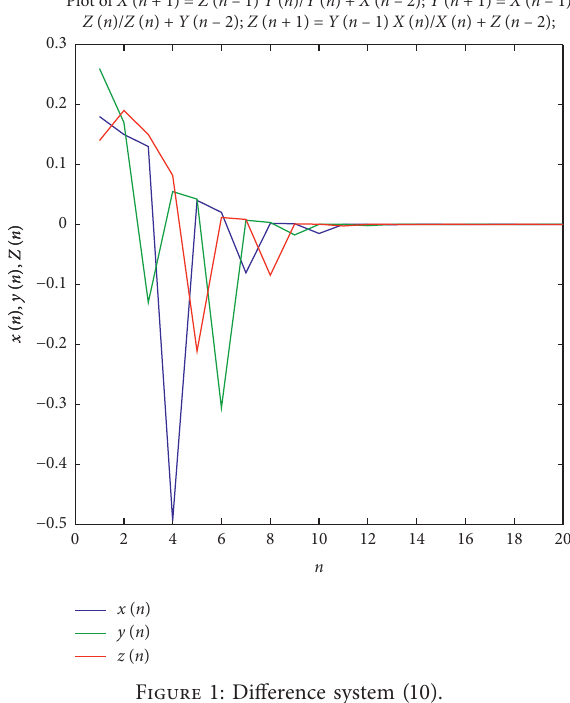
Figure 1: Difference system